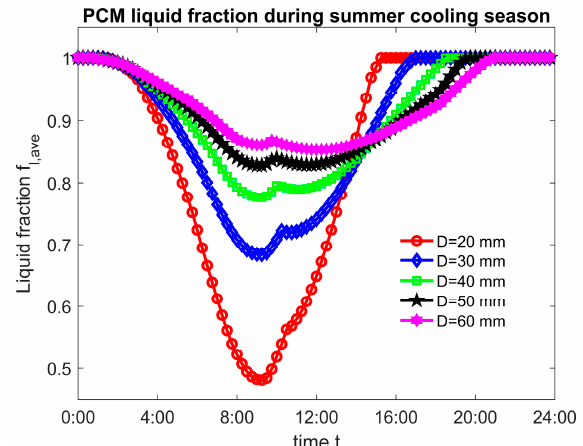
Figure 10. The PCM layer average liquid fraction during the summer cooling season with different layer thicknesses.